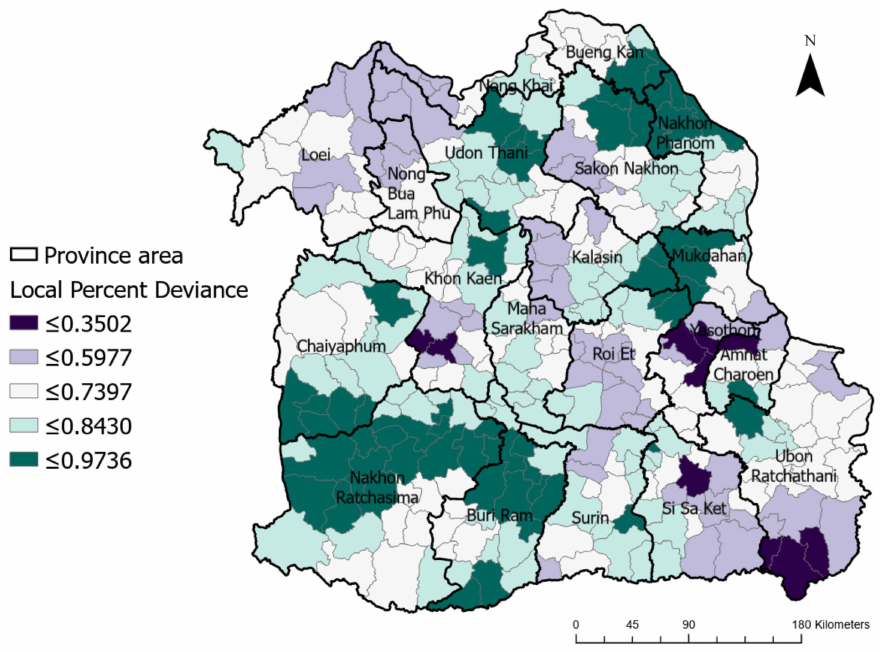
Figure 5. Local percentage deviance based on GWR results across the study area.